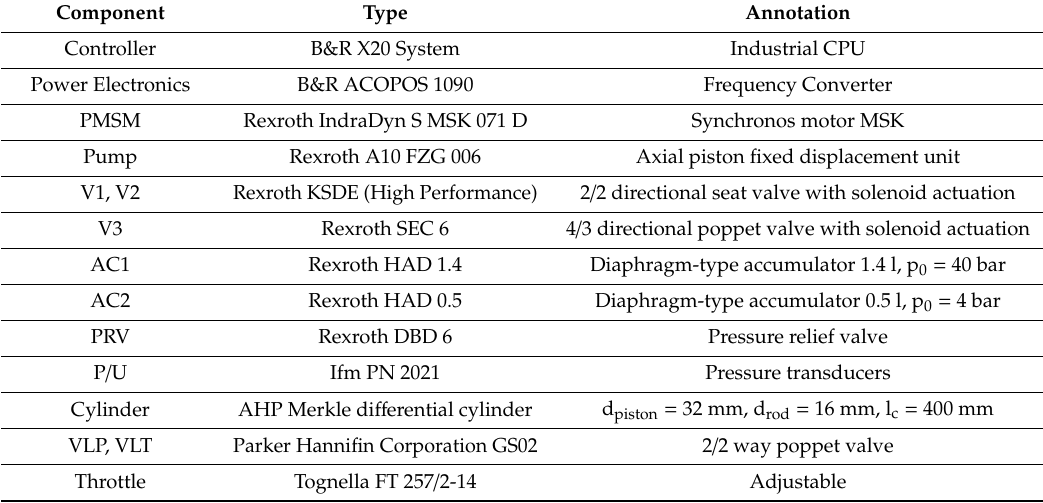
Table 1. Components list of test rig in Figure